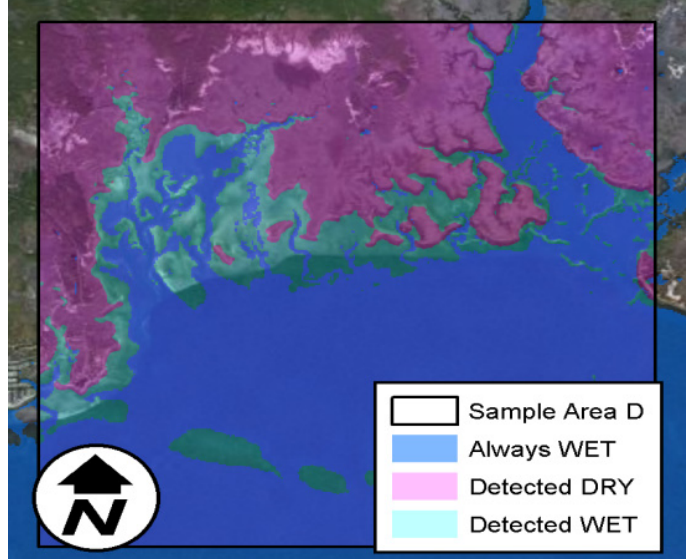
Figure 4. Example of inundation detection output delivered by the synergetic method. Note that the darker green areas in the figure are areas classified as “Always WET” but show up as ground in the aerial